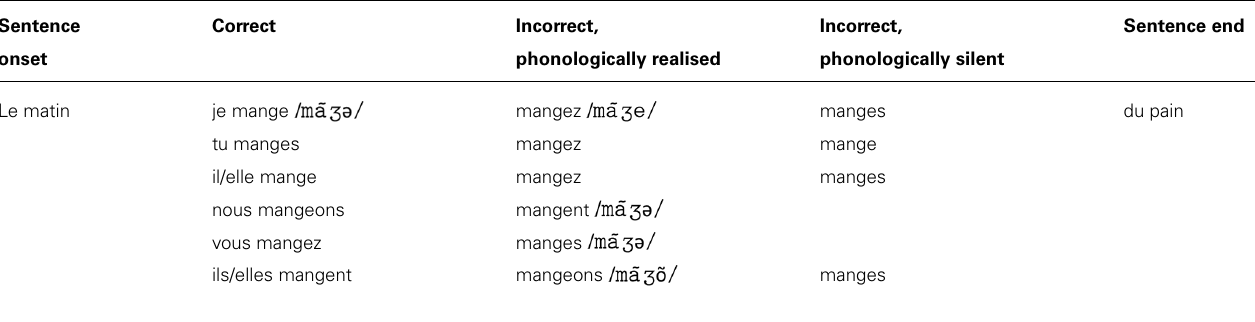
Table 1 | Examples of the three sentence conditions (correct, incorrect and phonologically realized, incorrect and silent) for the six different verbal persons in French.